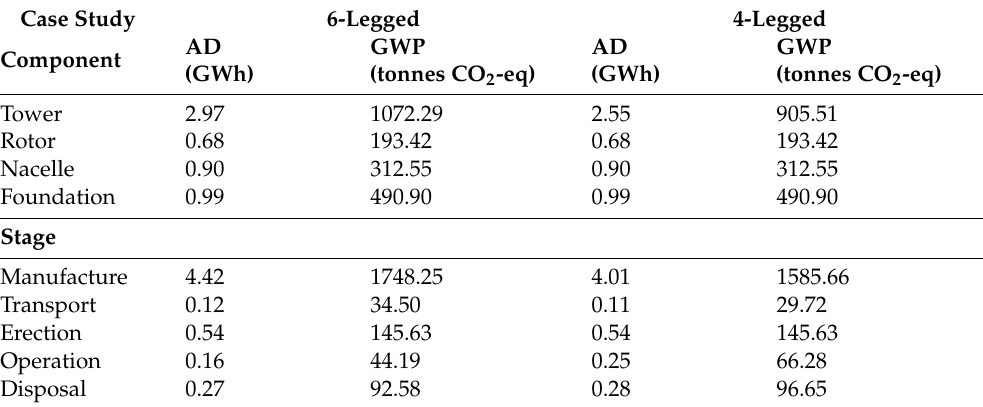
Table 7. LCA results per component and per stage.